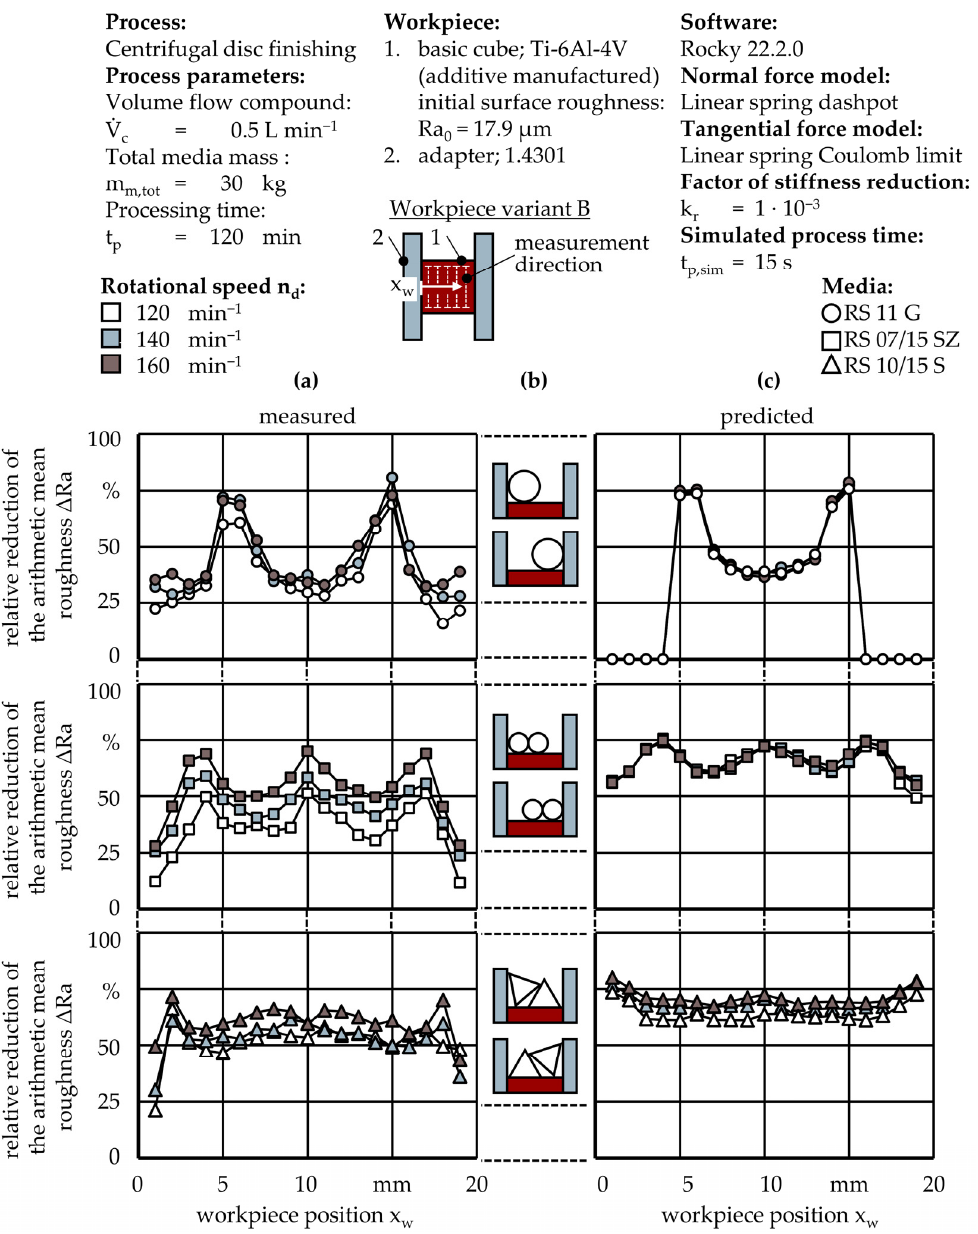
Figure 10. Workpiece variant B: ( a ) results of finishing experiments; ( b ) predominant contact constellations; ( c ) predicted finishing results.